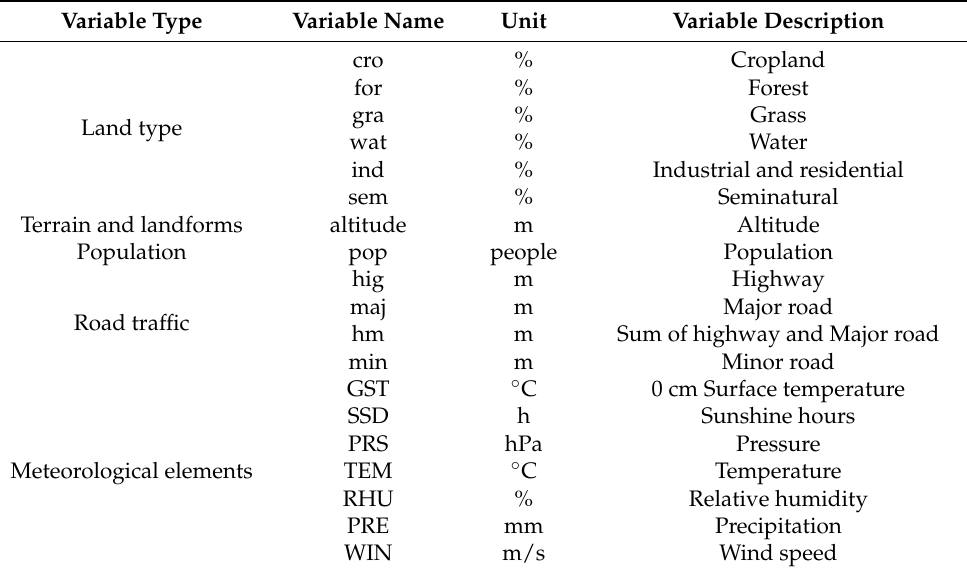
Table 1. Classification and description of independent